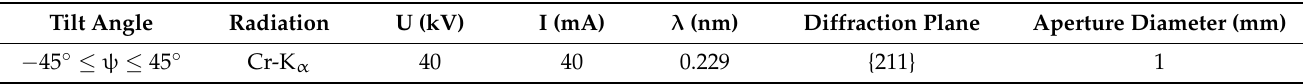
Figure 11. Comparison of simulated and measured track widths w track for 25 °C and 300 °C. Table 4. Relative deviations between simulated and measured track widths. Temperature (°C) Min. Relative Track Width Deviation (%) Max. Relative Track Width Deviation (%) 25